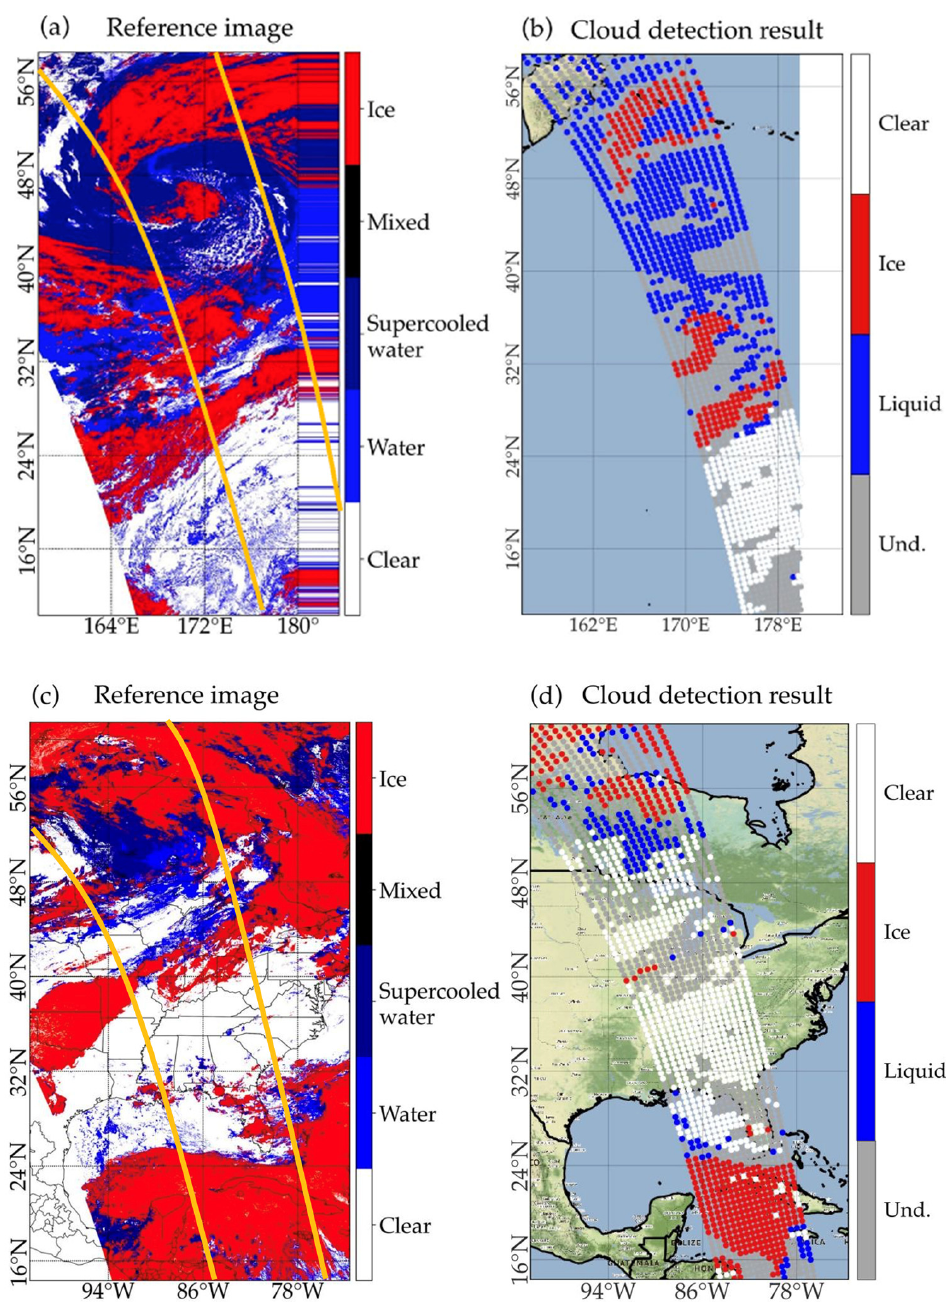
Figure 11. ( Top ): example for ocean background. ( a ) Pseudo-color image of the reference scene (date: 1 August 2022 18:58:23 orbit n. 19375. ( b ) Cloud detection result of this scene. ( Bottom ): example for land background. ( c ) Pseudo-color image of the reference scene (date: 1 August 2022 08:55:19 orbit n. 19369). ( d ) Cloud detection result of this scene. (Und. stands for undetermined).